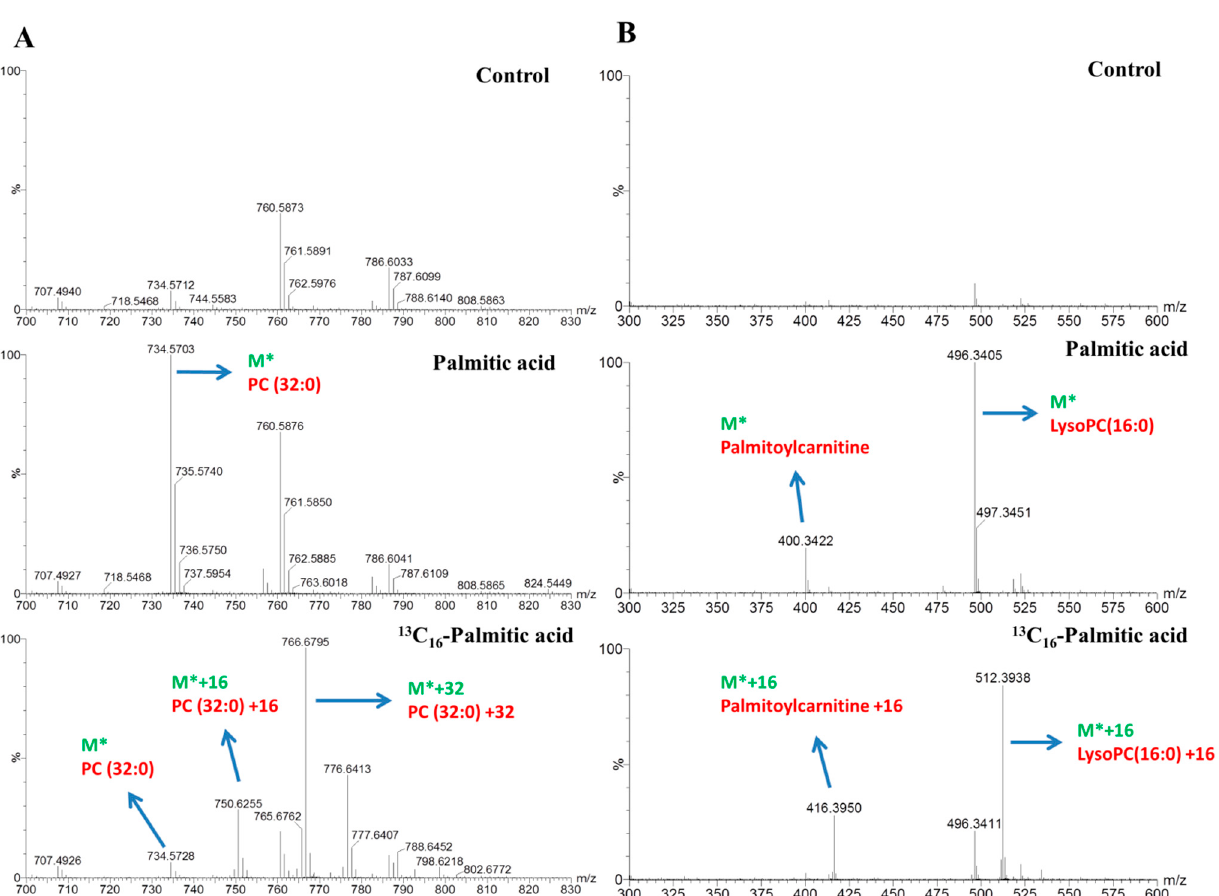
Figure 4. Illustration of the stable isotope-labeled C16:0 metabolite mass spectra. ( A ) The peaks of PC (32:0) (M*) and its isotopomers (M* + 16 or M* + 32) detected in HepG2 cells incubated with 0.3 mM palmitic acid and 13 C16-labeled palmitic acid respectively after 16-h treatment. ( B ) The peaks of palmitoylcarnitine and LysoPC (16:0) (M*) and its isotopomers (M* + 16) detected in HepG2 cells incubated with 0.3 mM palmitic acid and 13C16-labeled palmitic acid, respectively, after 16-h treatment. M* means the m / z in positive or negative mode.